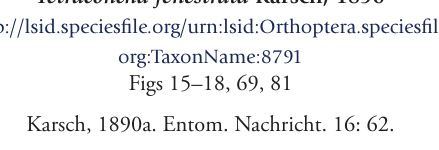
Table 1. Morphometric characters characterizing the stridulatory area of the species of the genus Tetraconcha . Length of stridulatory file Distance between left tegmen base and max Species (mm) width of lower cubital area (mm)